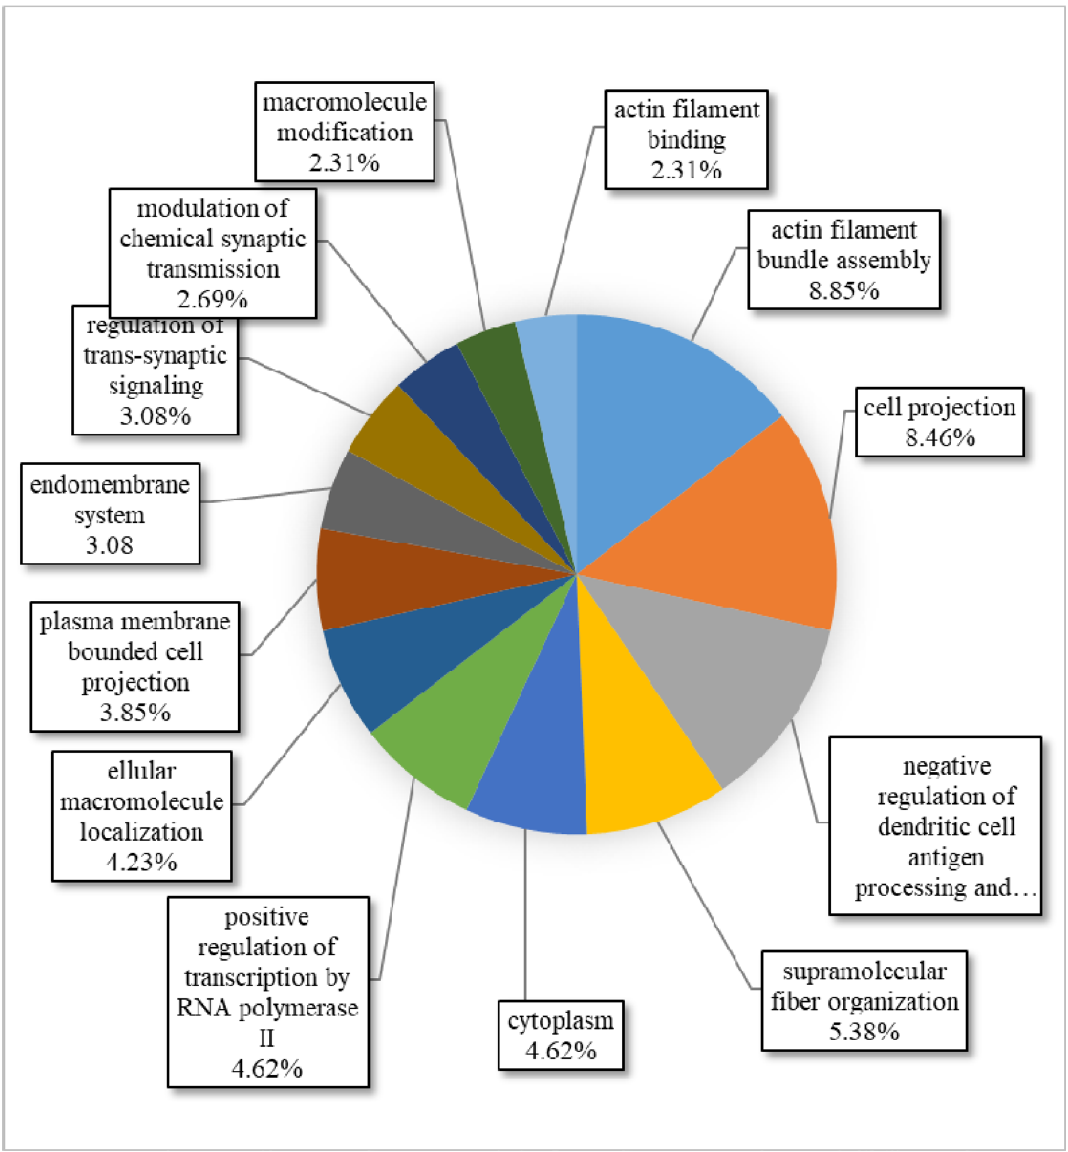
Figure 6. Circular diagram of the biological pathways involved by the genes reported in orthologous regions containing CNVs in H. sapiens , created by Cytoscape functional annotation tool (http:// www. cytos cape. org/): In this figure the name of each process and its percentage has been showed. Pathways with a contribution of less than 2% were removed from the some genes such as SYCP2, NPR2, EDN3 influencing birth weight, skeletal morphology and body size 67 , and finally network 4 including the genes like PRSS55, CRISP2 that are relate with immune system, antigens and antibodies 68 . Due to the high conservation of the genes between humans and sheep 69 , genes that are known to be related to complex human traits may also be important for related traits in sheep. However, further research will be needed to formally test the functional relevance of these genes. QTLs overlapping with identified CNVRs. To further reveal the CNVRs associated with sheep eco- nomic traits, the detected CNVRs were compared with quantitative trait loci (QTLs) in the sheep QTL database. We found 121 CNVRs overlapping with 171 QTLs, including milk production and quality, growth and carcass traits, reproduction performance, fleece yield, fecal egg counts, tail fat deposition, horn type and health-related traits (Additional file Table S1). Many studies have shown that CNVRs contain QTLs associated with important economic traits in animals 50,70 . Therefore, the CNVRs detected in this study were compared with the QTLs reported in the sheep QTL data- base. The QTL categories found in this study were basically identical to those found in previously reported studies 50,52,71 . For example, the health-related QTLs found included fecal egg count QTLs, and worm count QTLs